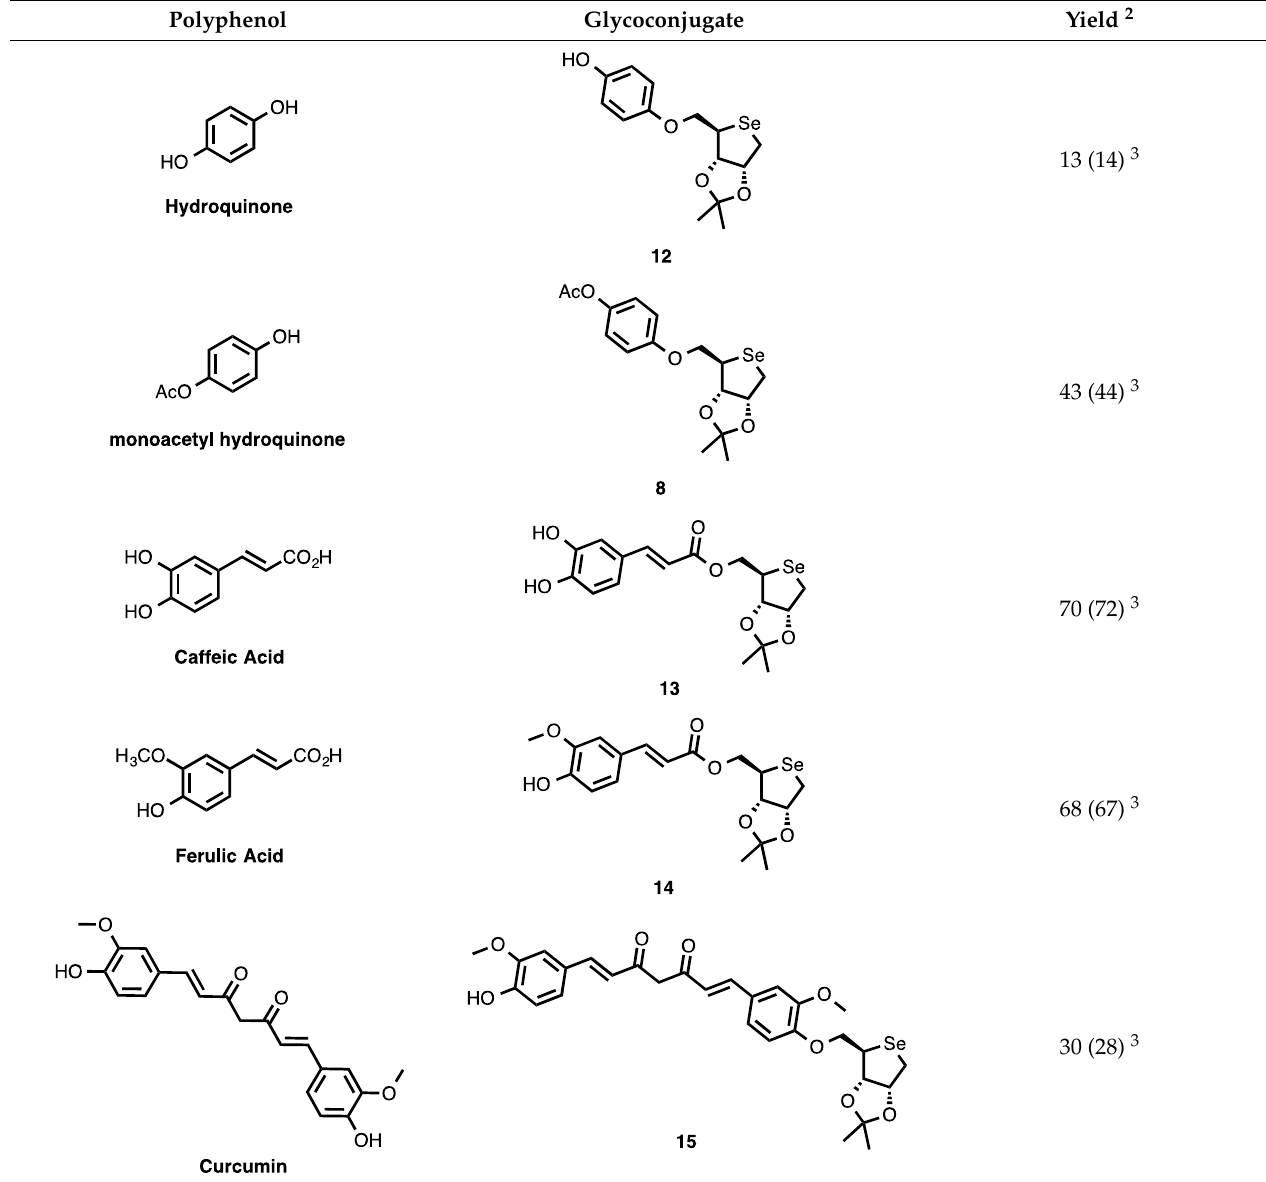
Table 2. Scope with respect to polyphenolic substrates 1 .